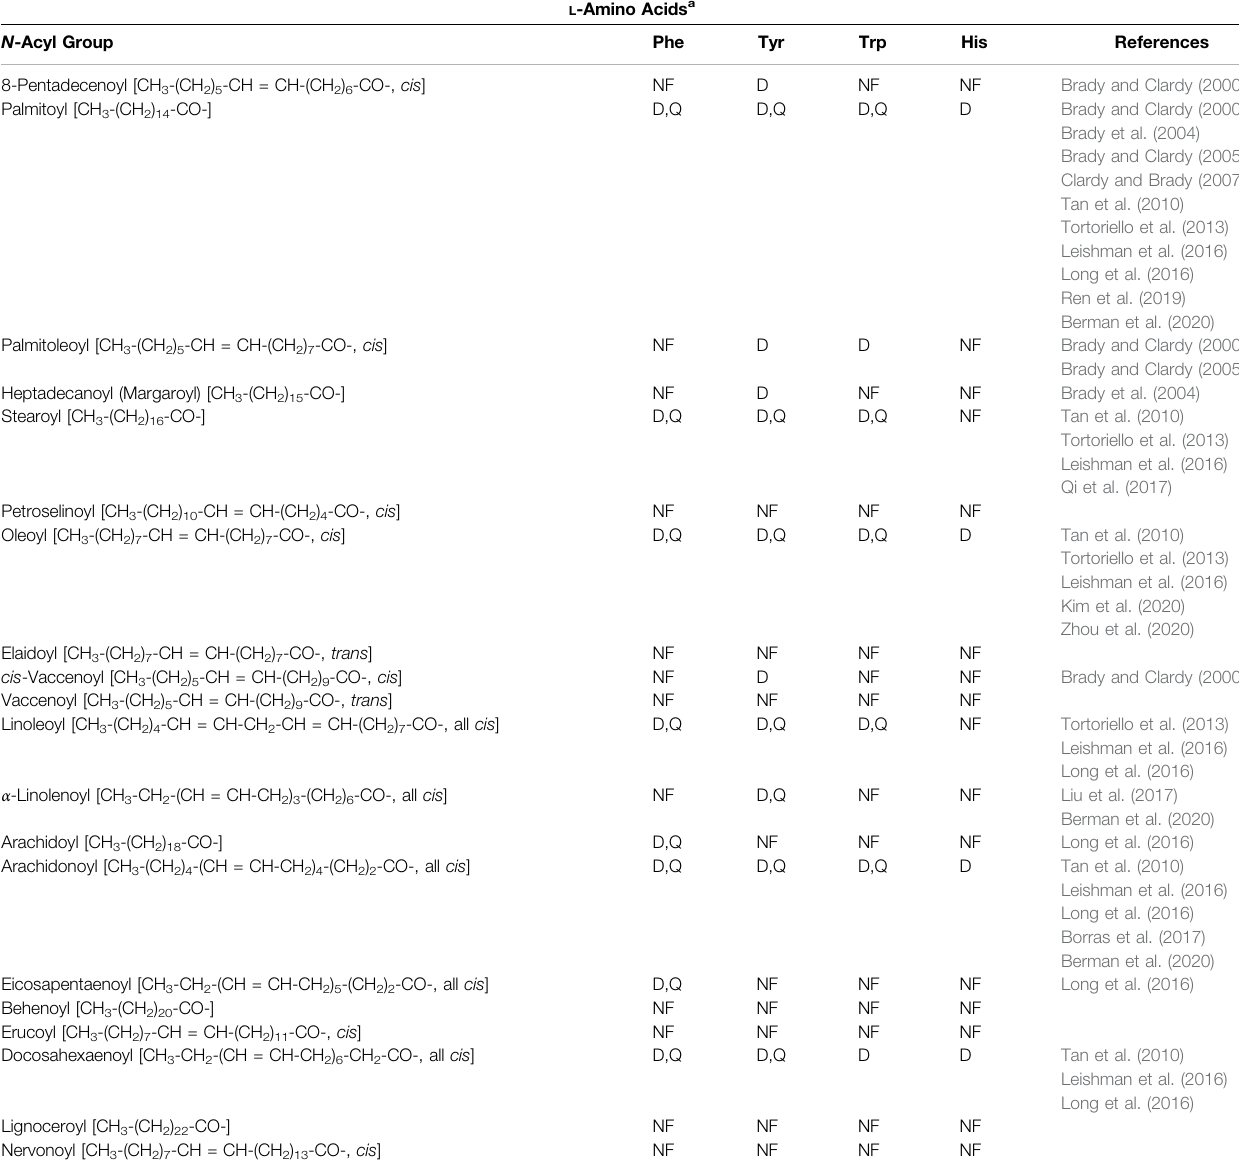
TABLE 1 | ( Continued ) N -Acyl Aromatic Amino Acids Identi fi ed from Living